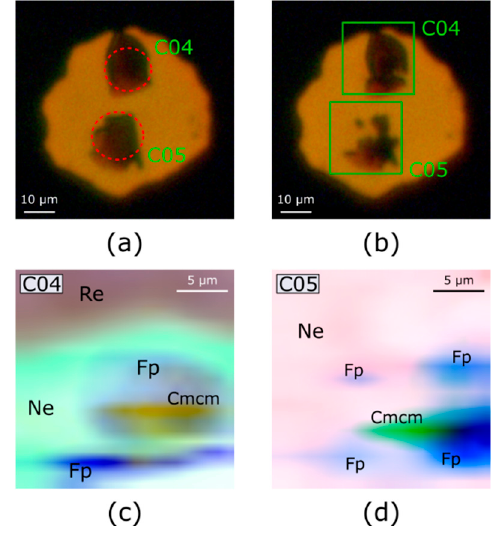
Figure 6. Optical microscope images of two crystals of (Mg,Fe)O (named C04, C05) at 53.5(5) GPa, before ( a ) and after ( b ) pulsed laser heating and X-ray diffraction maps of the quenched products at the locations of C04 ( c ) and C05 ( d ) crystals. The approximate heated areas are depicted as red dashed circles in ( a ). The areas of diffraction mapping are shown as green rectangles in ( b ), for crystals C04 and C05, respectively. The color intensity is proportional to the intensity of the corresponding reflections used for mapping. Diffraction lines and color coding are as follows: for crystal C04 ( c ) — the (211) reflection of Re for the gray region, the (111) reflection of Ne for the light green region, the (220) reflection of ferropericlase (Fp) for the blue region, the sum of (006) and (023) reflections of the hp-(Mg,Fe) 3 O 4 (Cmcm) for the orange region; for crystal C05 ( d ) — the sum of the (111) and (200) reflections of Ne for the pink region, the sum of (200) and (220) reflections of ferropericlase (Fp) for the blue region, the (023) reflection of the hp-(Mg,Fe) 3 O 4 (Cmcm) for the dark green region. Representative powder diffraction patterns of each region are presented in Figures S1 and S2.